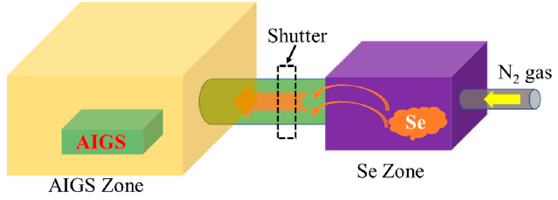
Figure 3. Schematic of the two-zone annealing furnace.